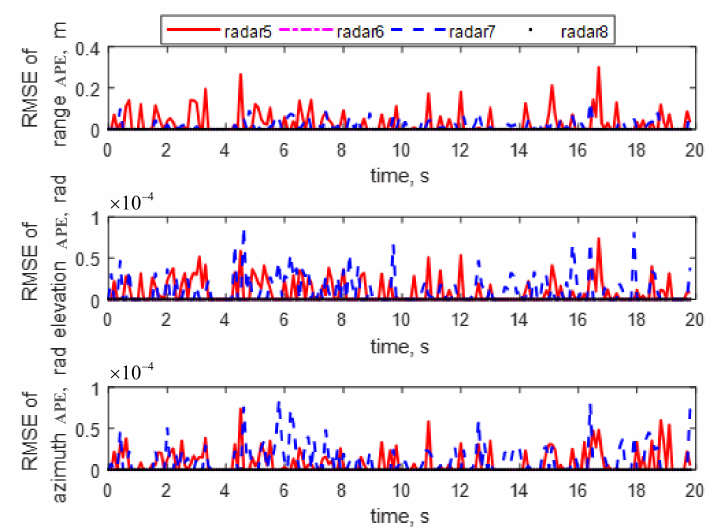
Figure 4. RMSE of the attack parameter estimations for radars 5–8.